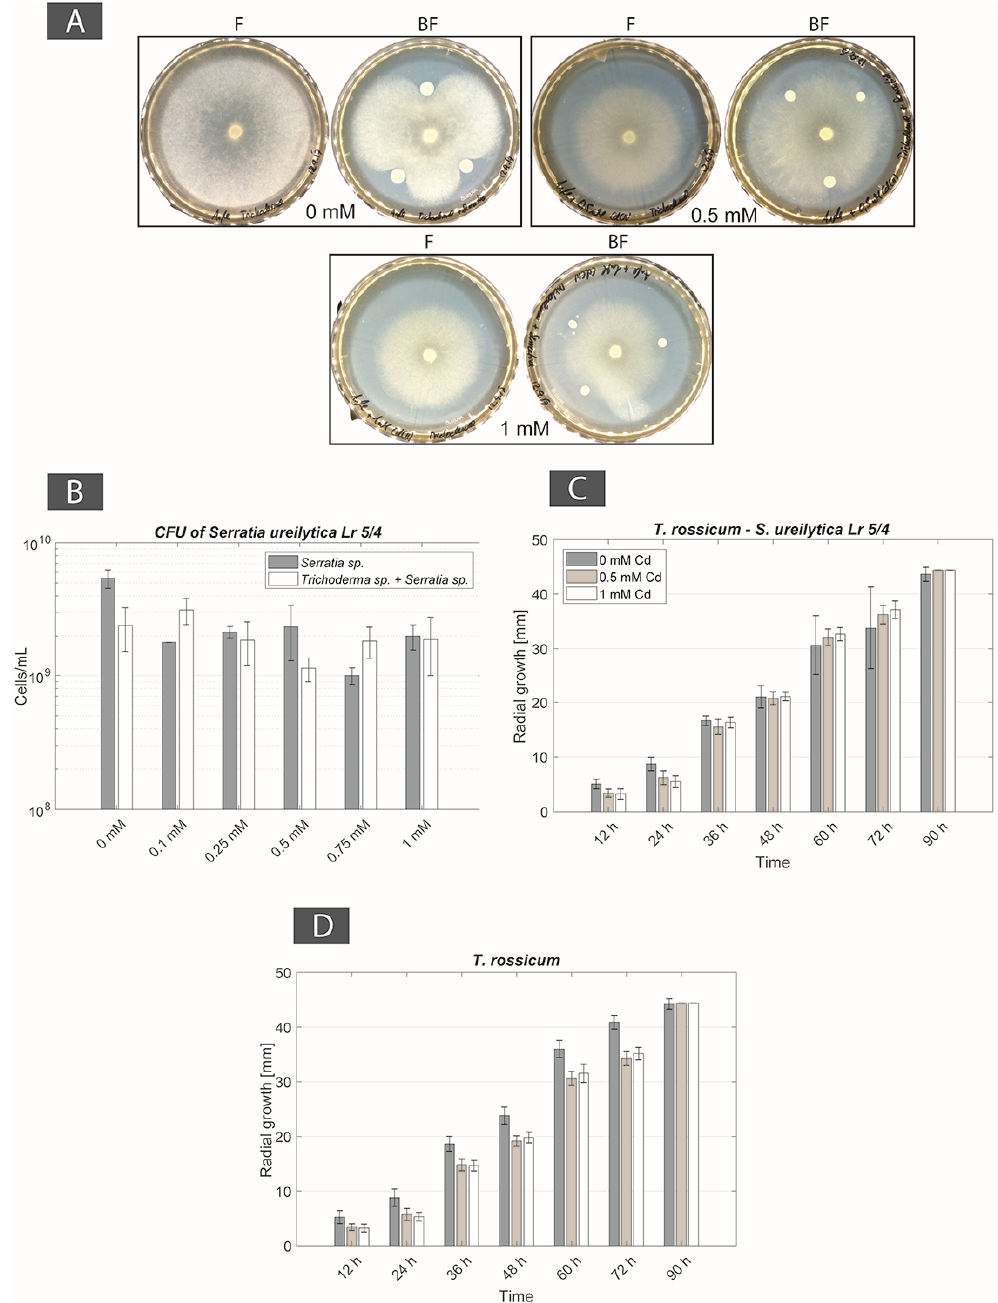
Figure 3. ( A ) Photographs of mono-cultures of Trichoderma rossicum (F panels) and co-cultures of